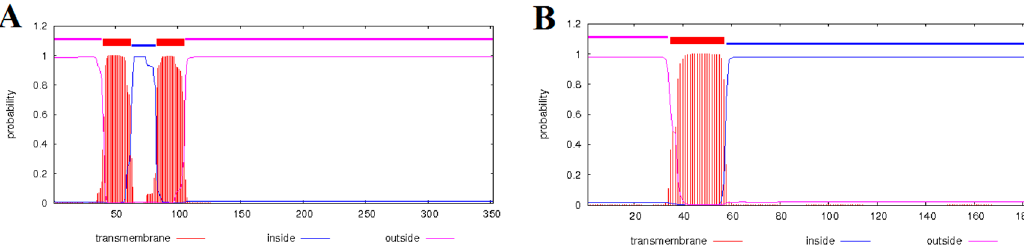
Figure 3. Comparison of transmembrane domains of proteins encoded by cox2 ( A ) and orf558 ( B ).